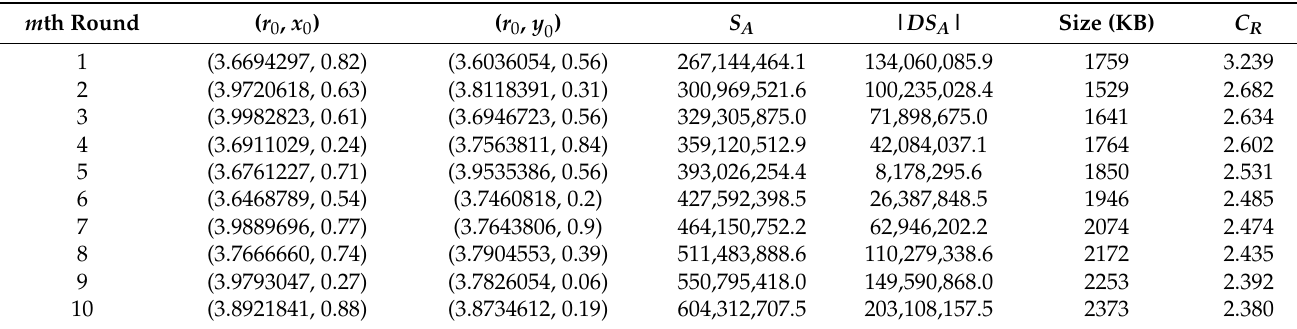
Table 3. The best key pairs among 10 encryption times for DEM A. | DS A | means the absolute S A difference compared to the original one. S A is the absolute configurational